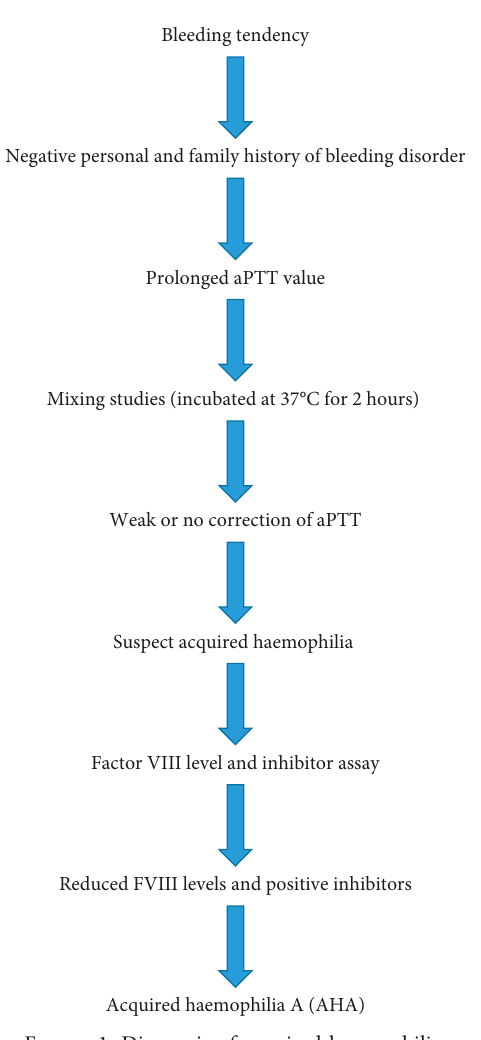
Figure 1: Diagnosis of acquired